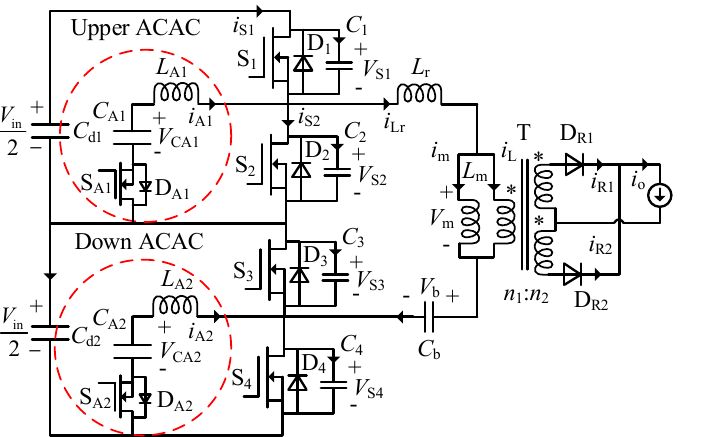
Figure 2. The ITLDC with proposed ACACs. Where the * represents the dotted terminal of the transformer and the circuits in the red circles are the proposed ACACs.